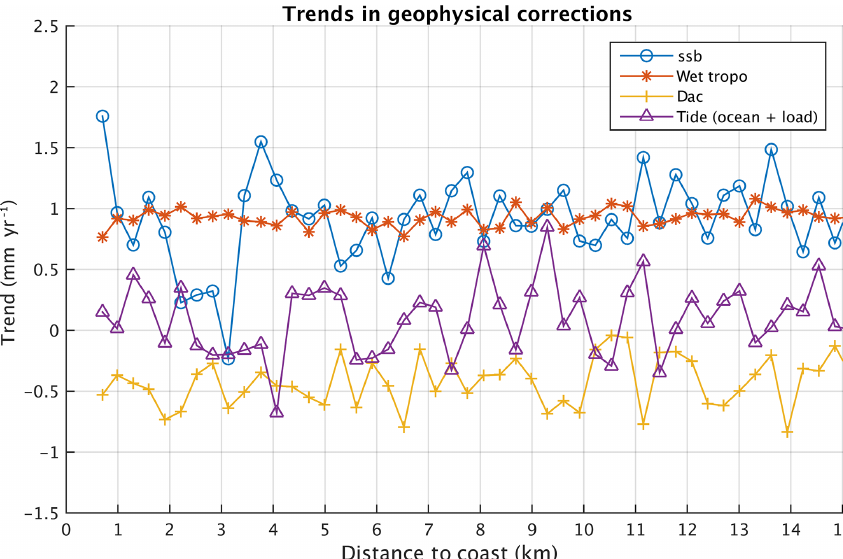
Figure 5. Trends in the geophysical corrections (ssb, wet tropospheric correction, dynamic atmospheric correction, DAC, and ocean tide plus ocean loading tide) as a function of distance to the coast. Note that the vertical scale is different from Fig.